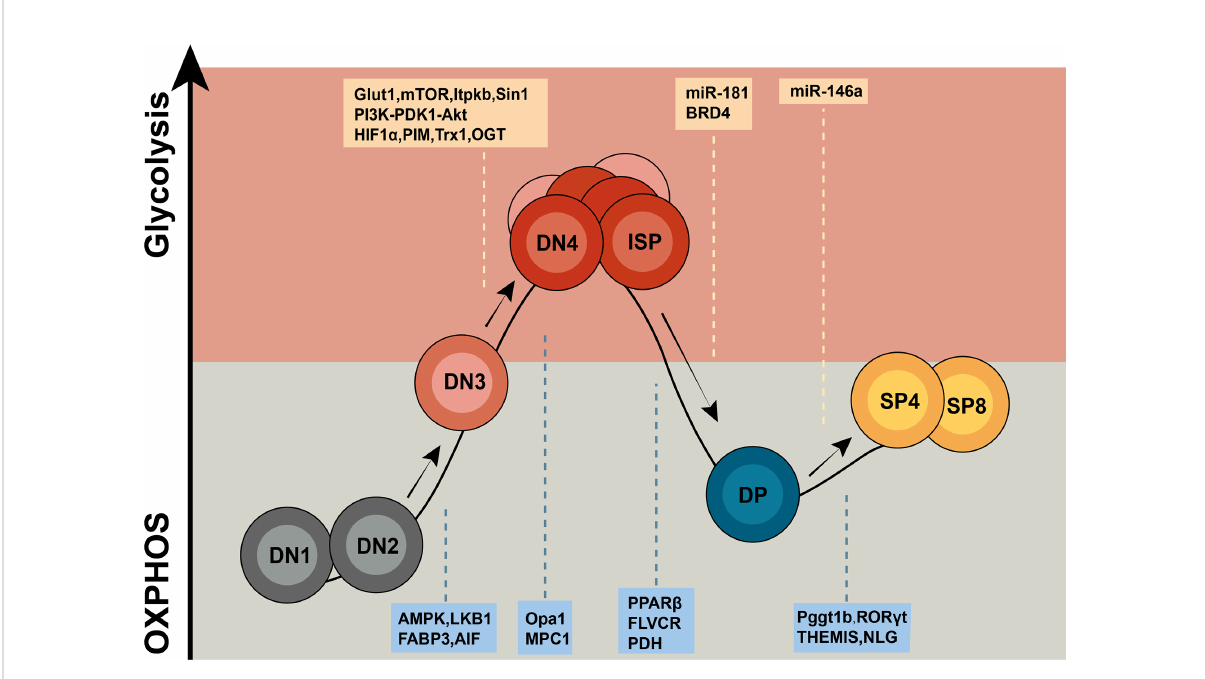
FIGURE 1 Overview of metabolic regulators in T cell development. Thymocytes display distinct metabolic pro fi les depending upon their states of development. DN1 and DN2 T cells are metabolically quiescent and adopt a basal level of nutritional intake, relying on OXPHOS as the primary approach of ATP production. Upon proliferation, T cells from the DN3b stage to early DP stage shift to a state of metabolic activation characterized by incremental nutrient uptake and elevated glycolysis. Then, T cells return to a resting state from the small DP stage to CD4 +/CD8+ SP stage. The letters in the yellow box represent glycolysis regulators, and the letters in the blue box represent OXPHOS regulators.